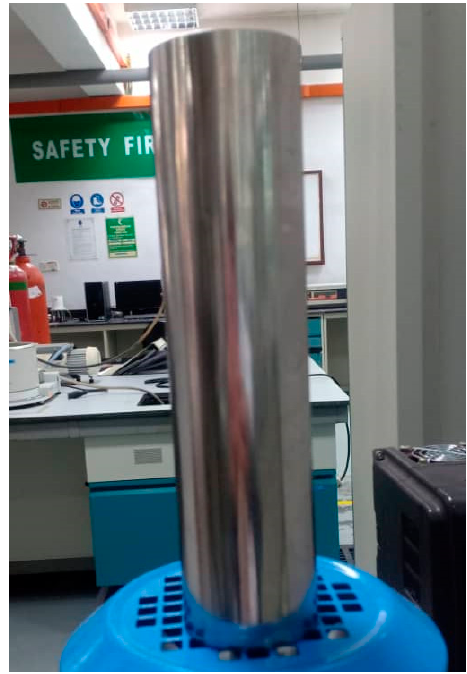
Figure 2. View of cylindrical crystallizer.